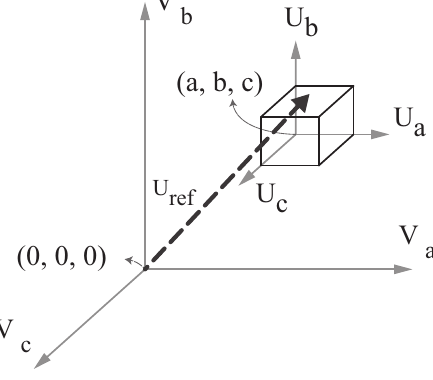
Figure 12. Sub-cube and the reference